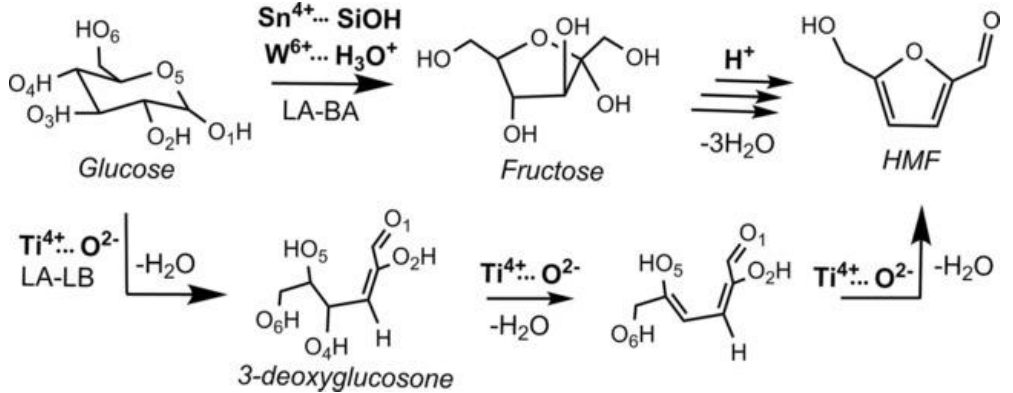
Figure 17. Two synergetic strategies converting glucose to HMF: (i) Glucose isomerization by cooperation between a Lewis acid and a proton donor (example systems are Sn/Beta and WO 3 ⋅ H 2 O) followed by fructose dehydration and (ii) stepwise glucose dehydration catalyzed by a Lewis acid-base pair (an example being Ti4c−O−Ti−OH on titania). Reproduced with permission from [44]; copyright (2018), John Wiley & Sons,